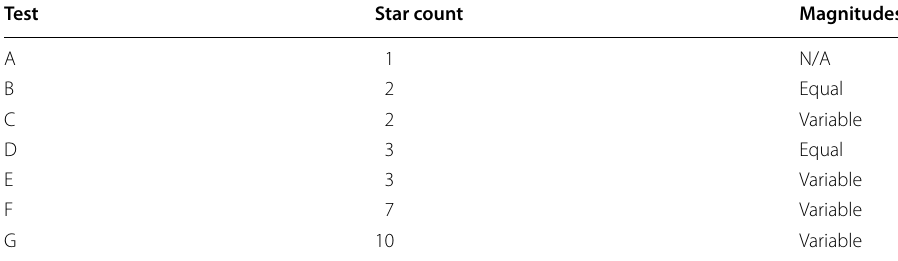
Table 1 Constellation tests performed Test Star